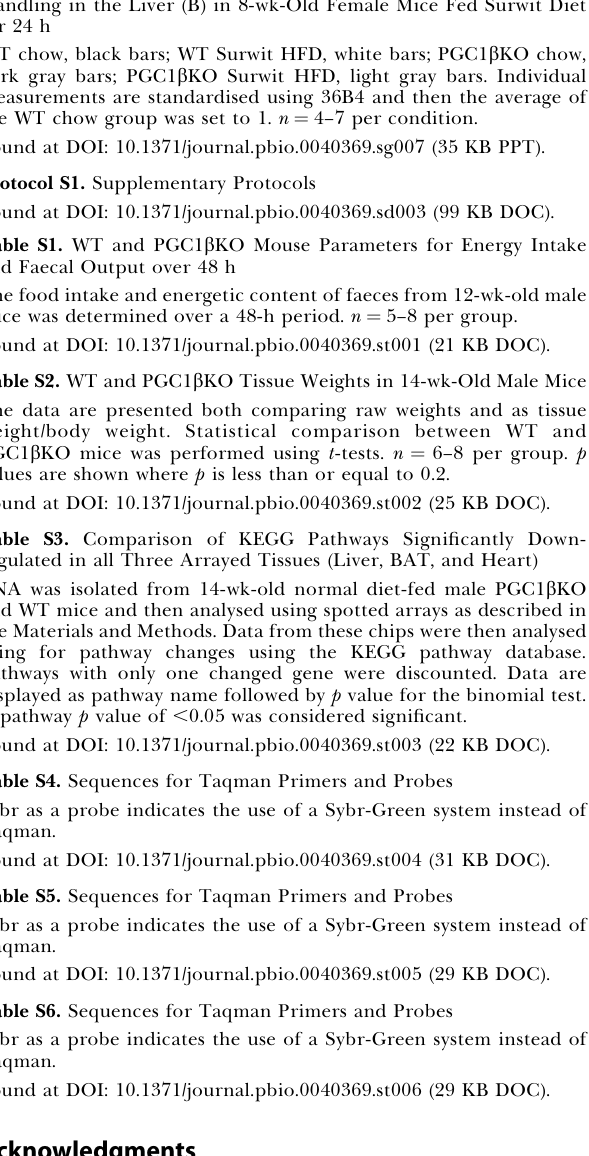
Figure S7. Gene Expression of PGC-1 a and PGC-1 b (A) and for a Selection of Genes Involved with Fatty Acid and Cholesterol Handling in the Liver (B) in 8-wk-Old Female Mice Fed Surwit Diet for 24 h WT chow, black bars; WT Surwit HFD, white bars; PGC1 b KO chow, dark gray bars; PGC1 b KO Surwit HFD, light gray bars. Individual measurements are standardised using 36B4 and then the average of the WT chow group was set to 1. n ¼ 4–7 per condition. Found at DOI: 10.1371/journal.pbio.0040369.sg007 (35 KB PPT).